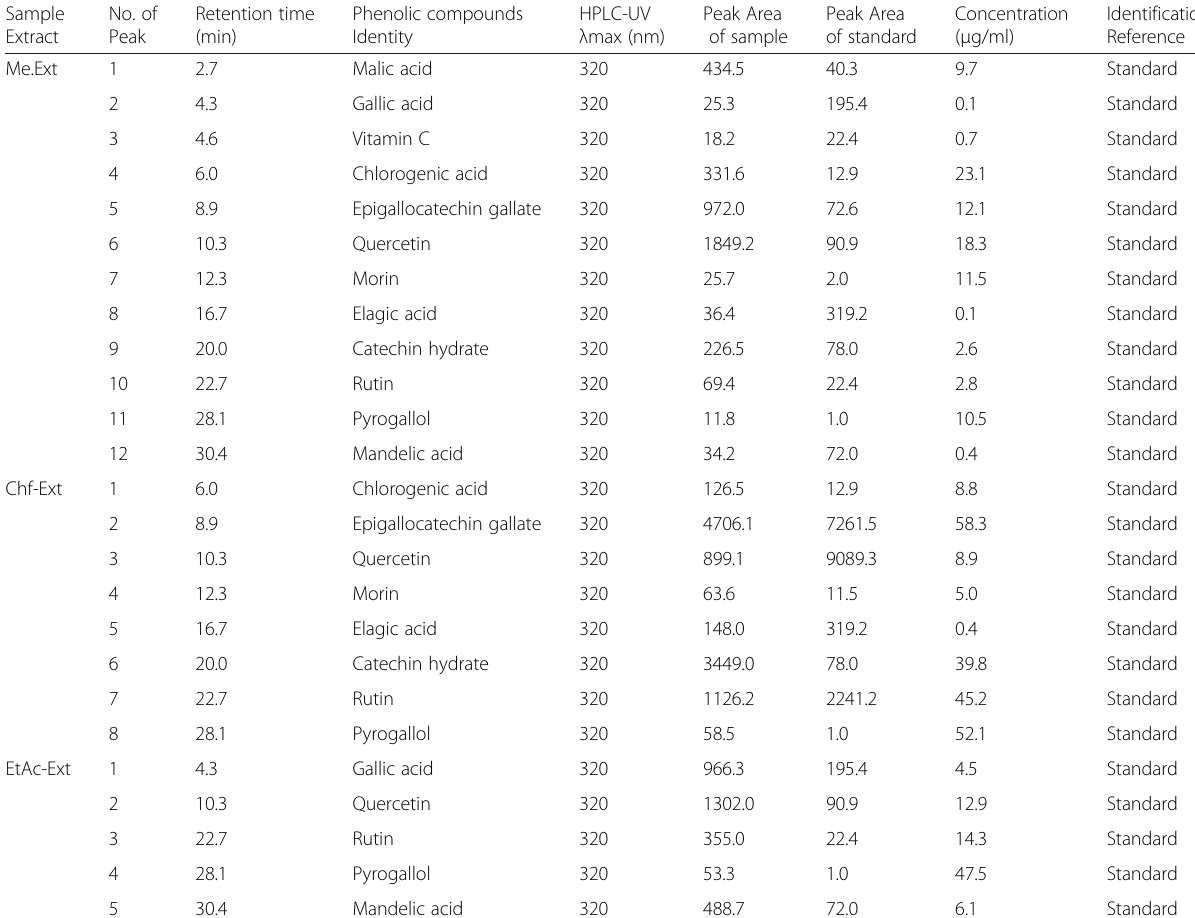
Table 2 Identification and Quantification of phenolic compounds in E. umbellata Thunb. fruit Me-Ext/fractions Sample Extract